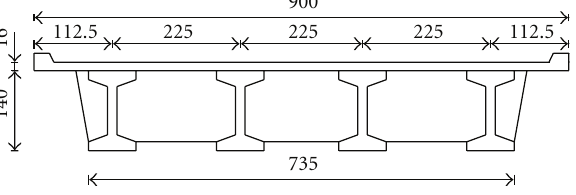
Figure 2: Typical transverse section of the superstructure.